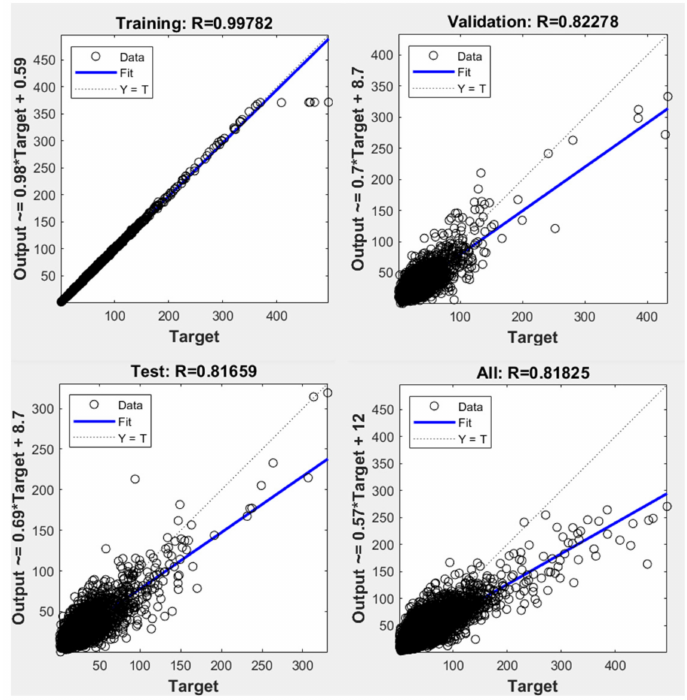
Figure 8. LSTM regression statistics for individual and the total set.